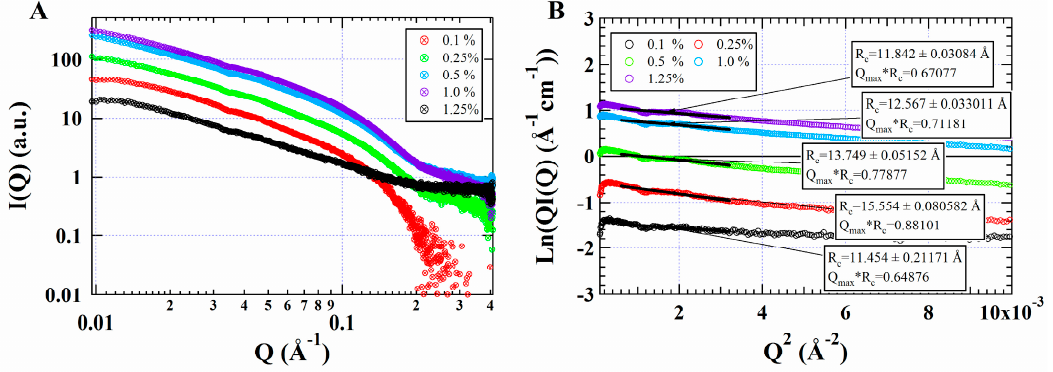
Figure 1. Rheology diagram of WPI fibrils solutions with the concentrations of 0.1 wt.%–1.25 wt.% ( A ) Steady flow curves and ( B ) the relationship between η 0 and of WPI fibrils concentrations (pH 2.0).